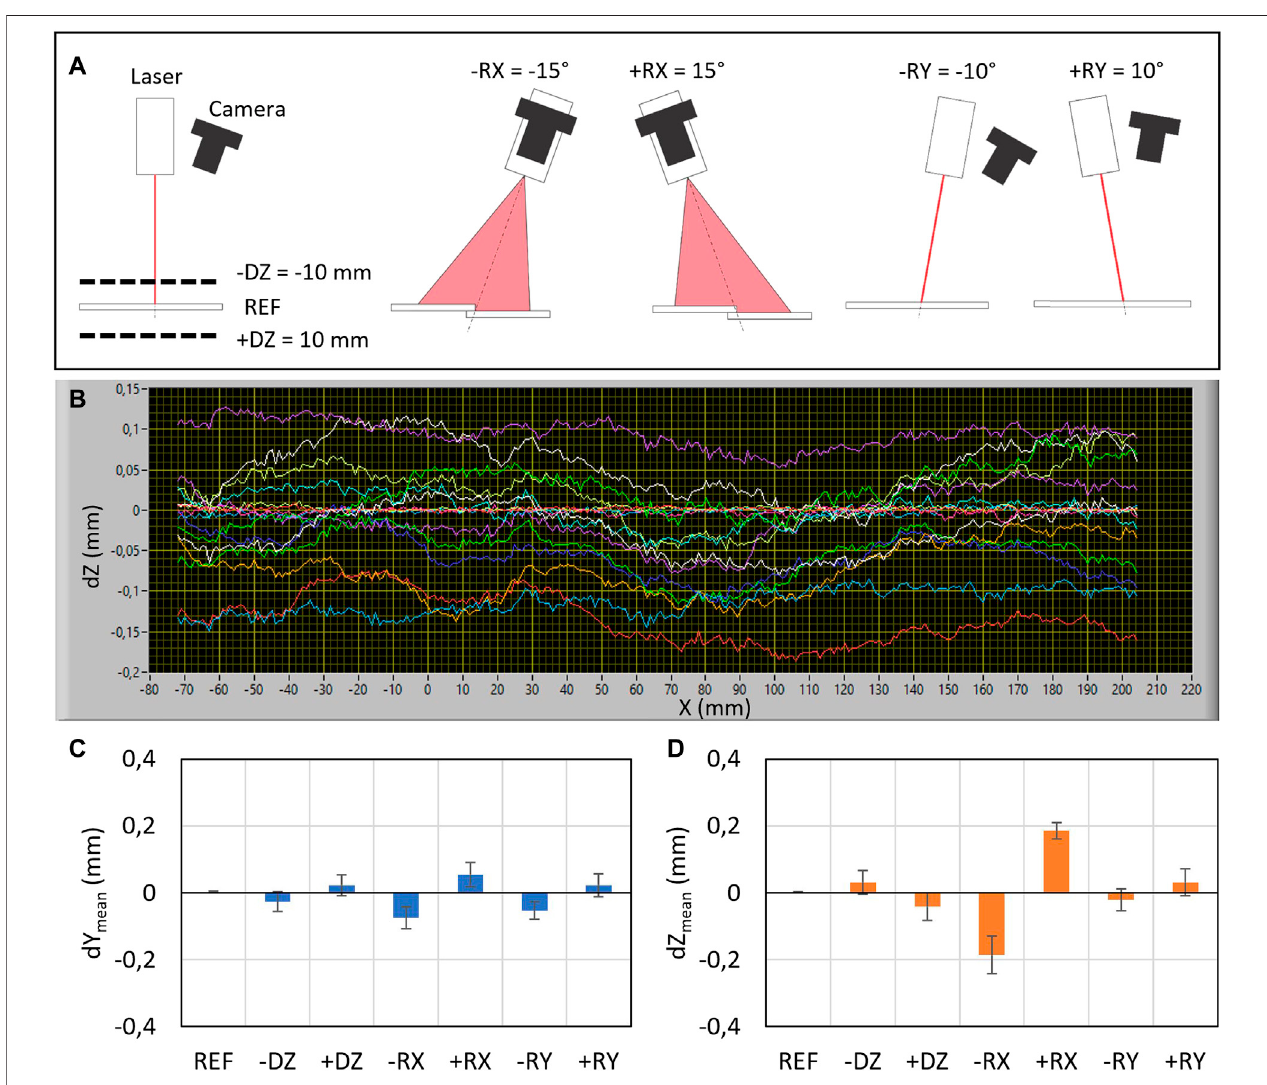
FIGURE 6 | Results of welding edge detection in terms of repeatability and accuracy for various poses of the laser pro fi lometer relative to the welding edge. (A) Schematic representation and names of examined poses ( − DZ, REF, +DZ, − RX, +RX, − RY, and +RY). (B) Deviationsof themeasured edgesin theverticaldirection (dZ) for various poses are shown in different colors. Mean deviations for various poses along the Y direction (C) and Z direction (D) . Error bars represent repeatability for 10 consecutive measurements.